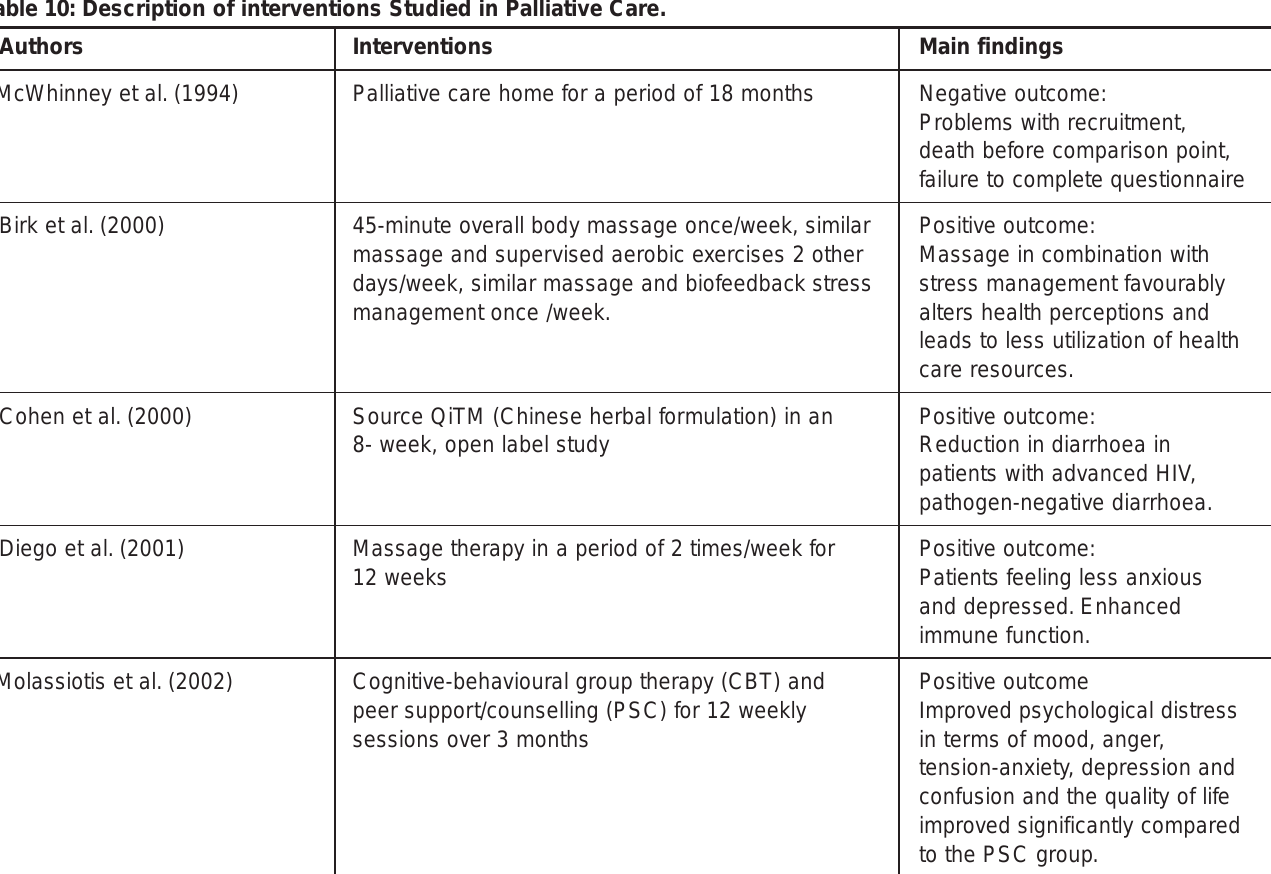
Table 10: Description of interventions Studied in Palliative